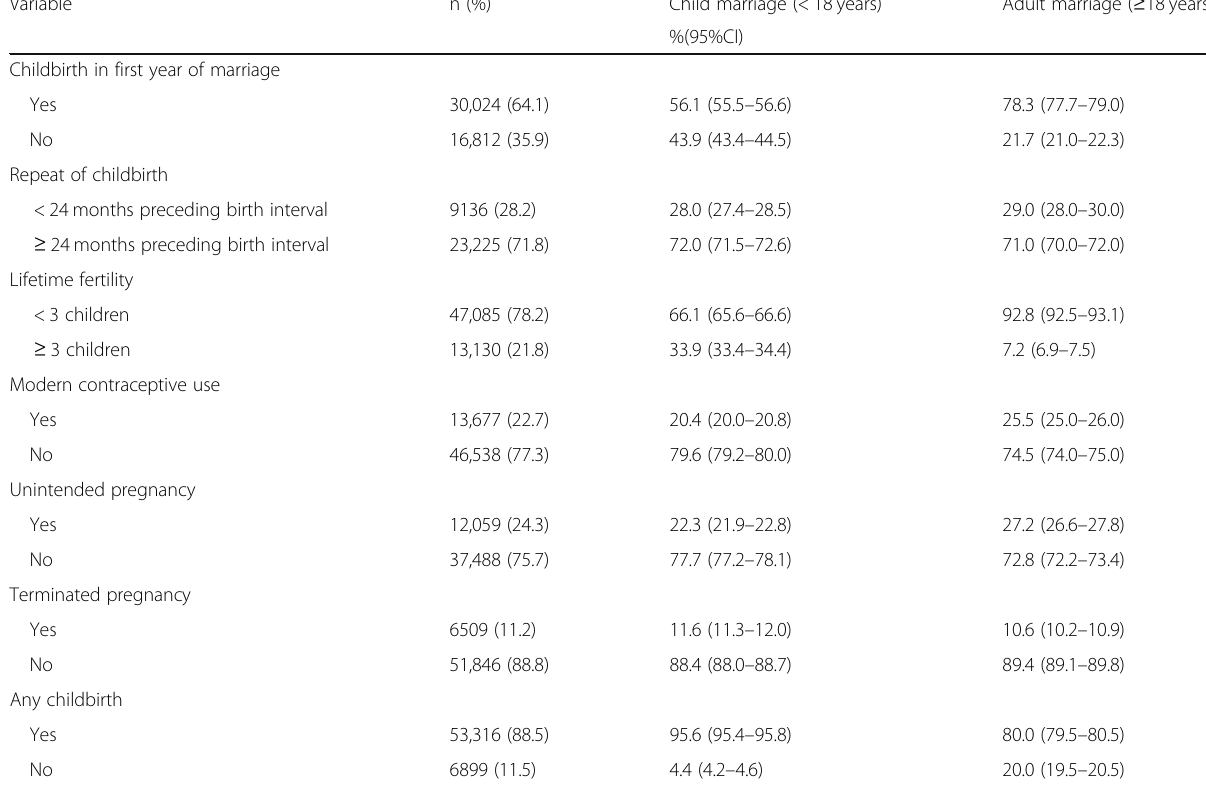
Table 3 Distribution of women ’ s age at marriage by fertility and fertility-control outcomes